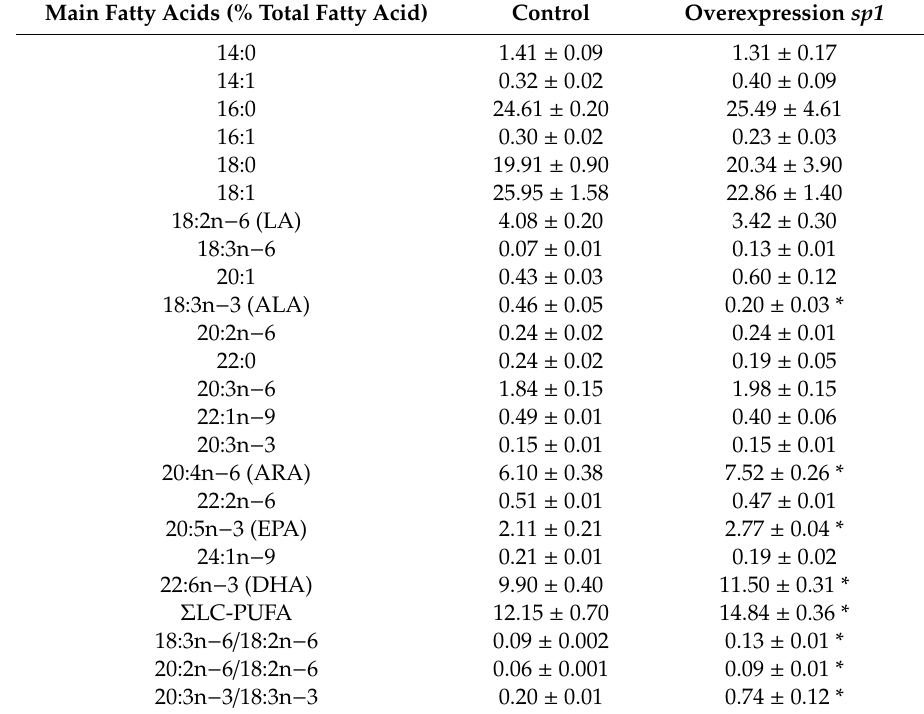
Table 2. Fatty acids composition of the rabbitfish S. canaliculatus hepatocyte line cells treated with sp1 mRNA overexpression or control 1